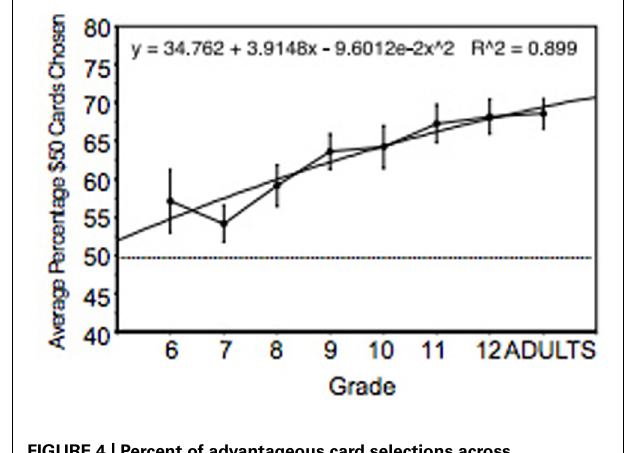
age accounted for 90% of the variance.Vertical bars indicate